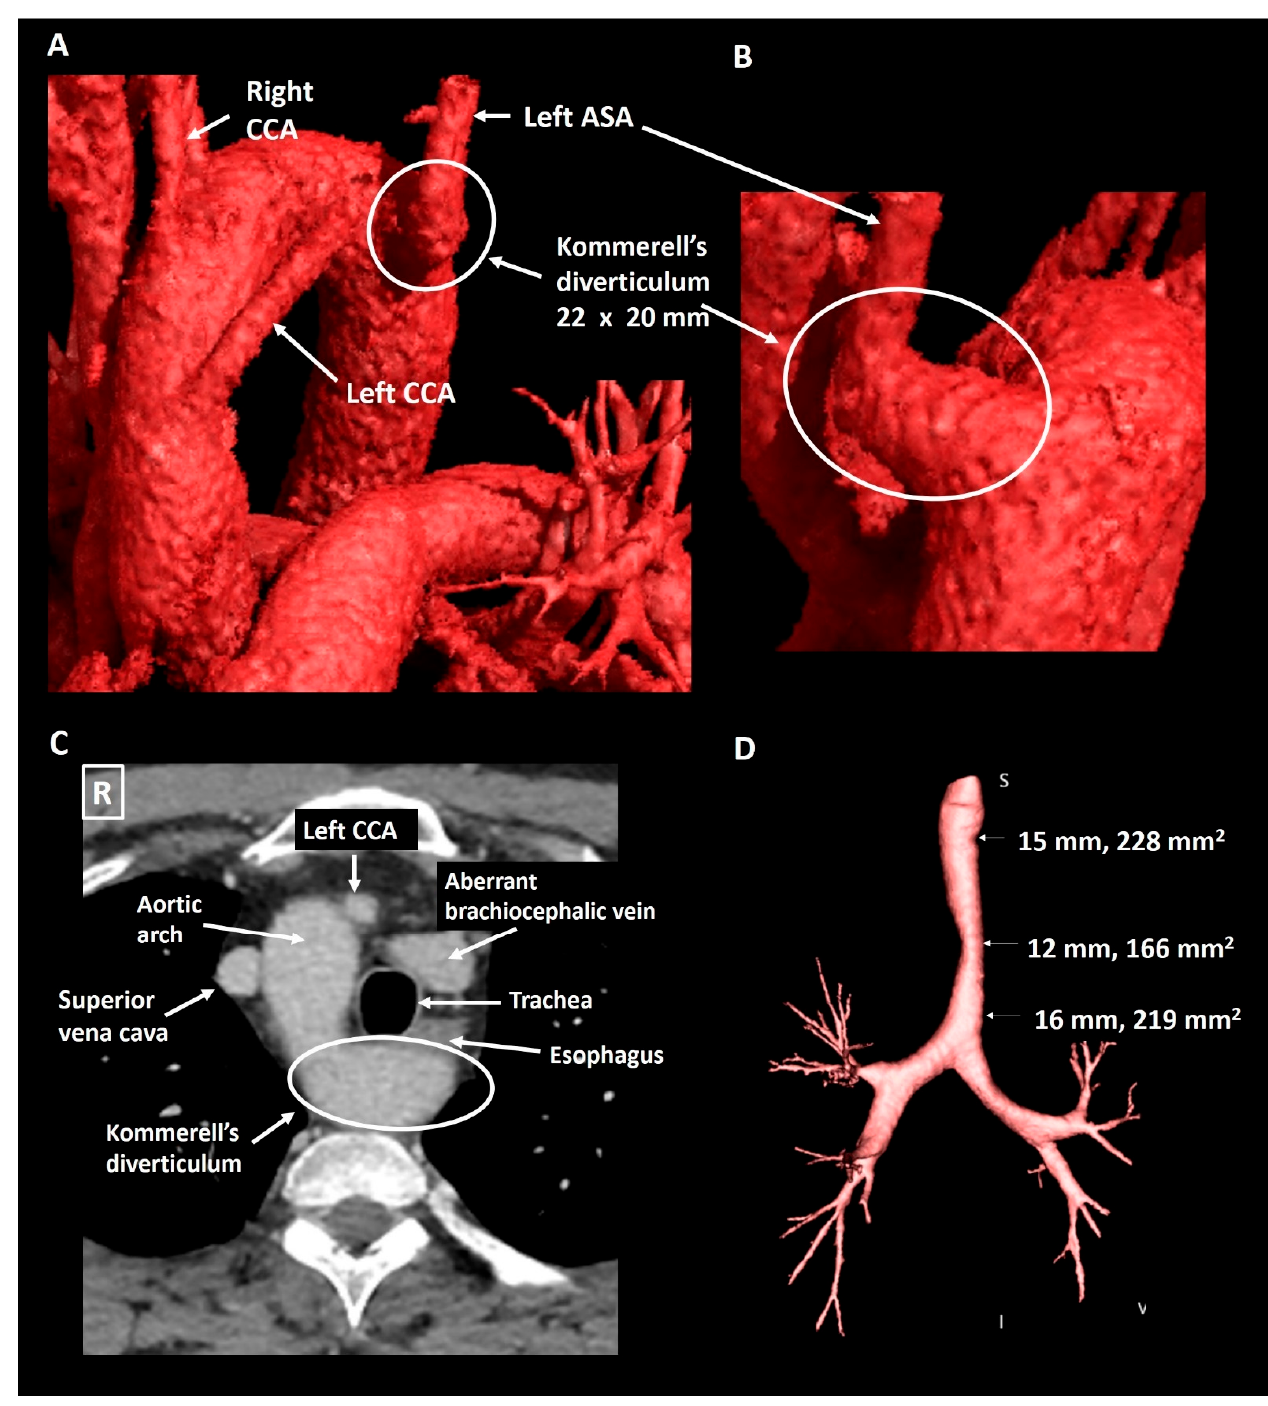
Figure 3. Patient 1. Panel ( A ) shows a CT-image reconstructed with global illumination rendering (iGIR) (Vitrea ® , Vital Images) in a anterolateral orientation depicting a right-sided aortic arch with an aberrant left subclavian artery. Panel ( B ) shows a close up of the oblique posterior view of a Kommerell’s diverticulum as the onset of the aberrant left subclavian artery. Panel ( C ) is an axial reconstruction depicting the anatomical relationship between the aortic arch, Kommerell’s diverticulum and an aberrant brachiocephalic vein which encircle the trachea resulting in mild compression. Panel ( D ) is a minimum intensity projection of the trachea showing mild external compression. ASA, aberrant subclavian artery; CCA, common carotid artery.